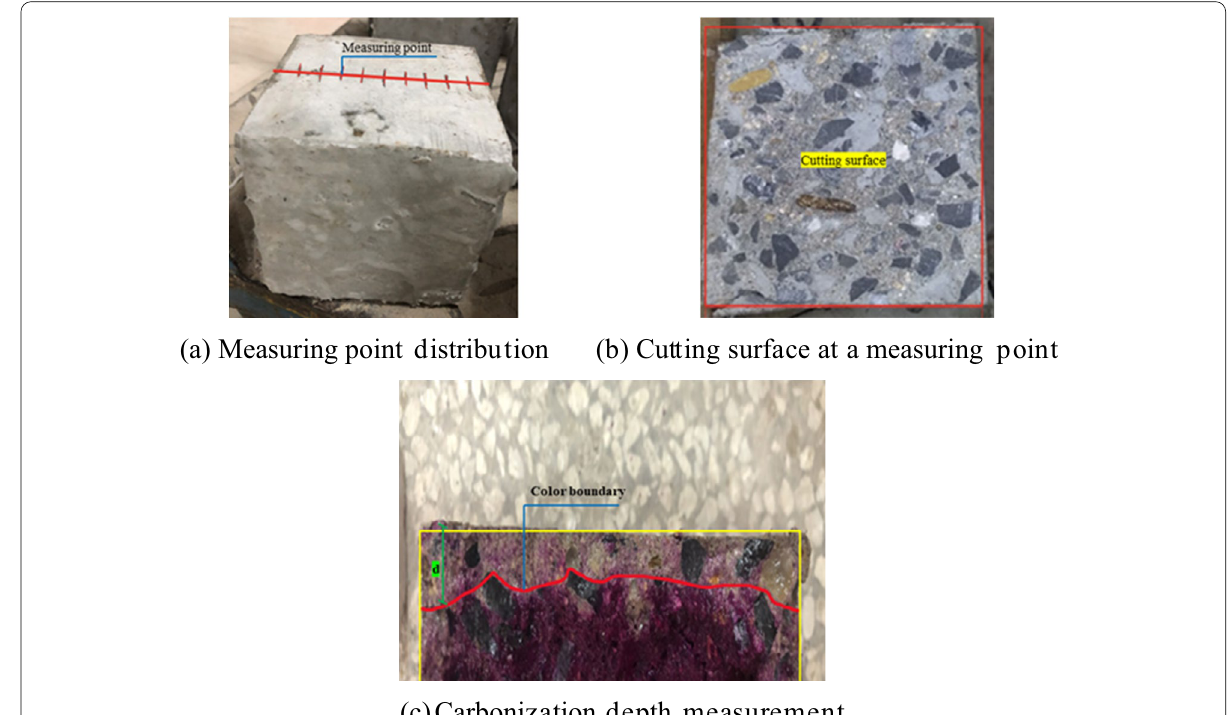
Fig. 2 Main steps of carbonization depth